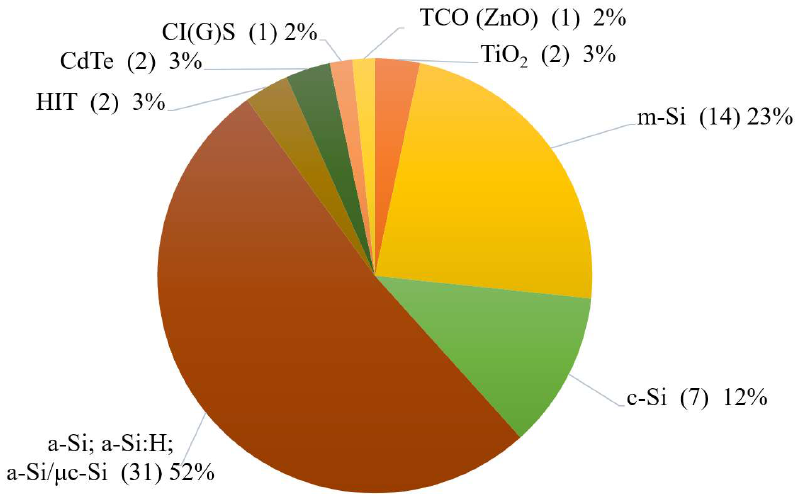
Figure 1. Numbers and percentages of research studies found on the different PV technologies.